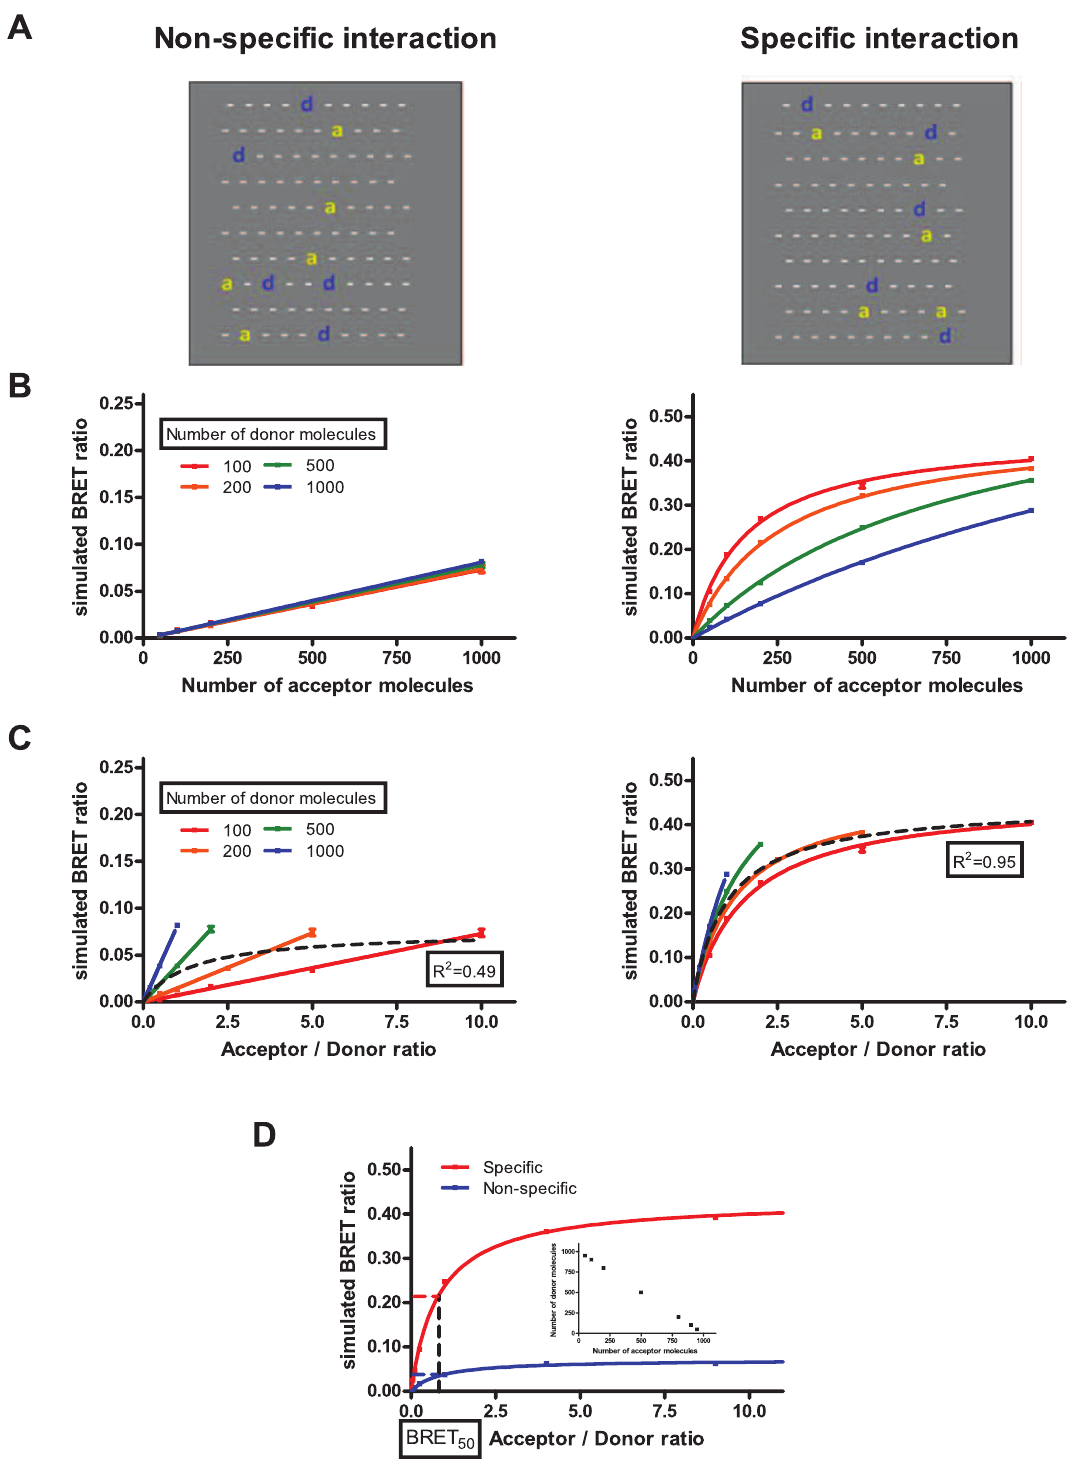
Figure 2. Monte Carlo simulations with various donor amounts. (A) Graphical representation of our simulations: two small membrane pieces in the case of non-specific (left panel) and specific (right panel) interaction, ‘d’ and ‘a’ represents donor and acceptor molecules, respectively, while ‘ 2 ‘ indicates empty hexagons. (B and C) Numbers of donor and acceptor molecules were varied from 100 to 1000 for each. BRET ratio was calculated after 1000 simulation time steps based on the total number of neighboring donor-acceptor pairs. Simulated BRET ratio was plotted as a function of the number of acceptor molecules (B) or acceptor/donor ratio (C). Simulations were performed with association and dissociation probabilities for non-specific (left panels) and specific (right panels) interactions (Table 2). (D) Simulations performed for non-specific and specific interactions, when total amount of donor and acceptor were fixed (insert). Curves were fitted using either linear regression or non-linear regression equation assuming a single binding site (GraphPad Prism). n=5, mean + / 2 SEM.